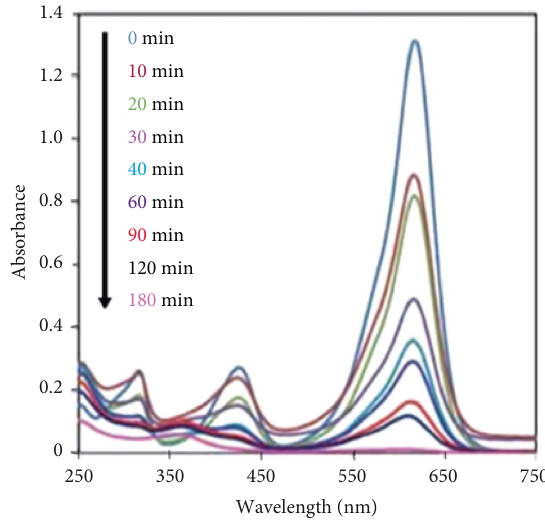
Figure 3: UV-Vis absorption spectra of photocatalytic degradation of methylene blue dye in the presence of green ZnO NPs